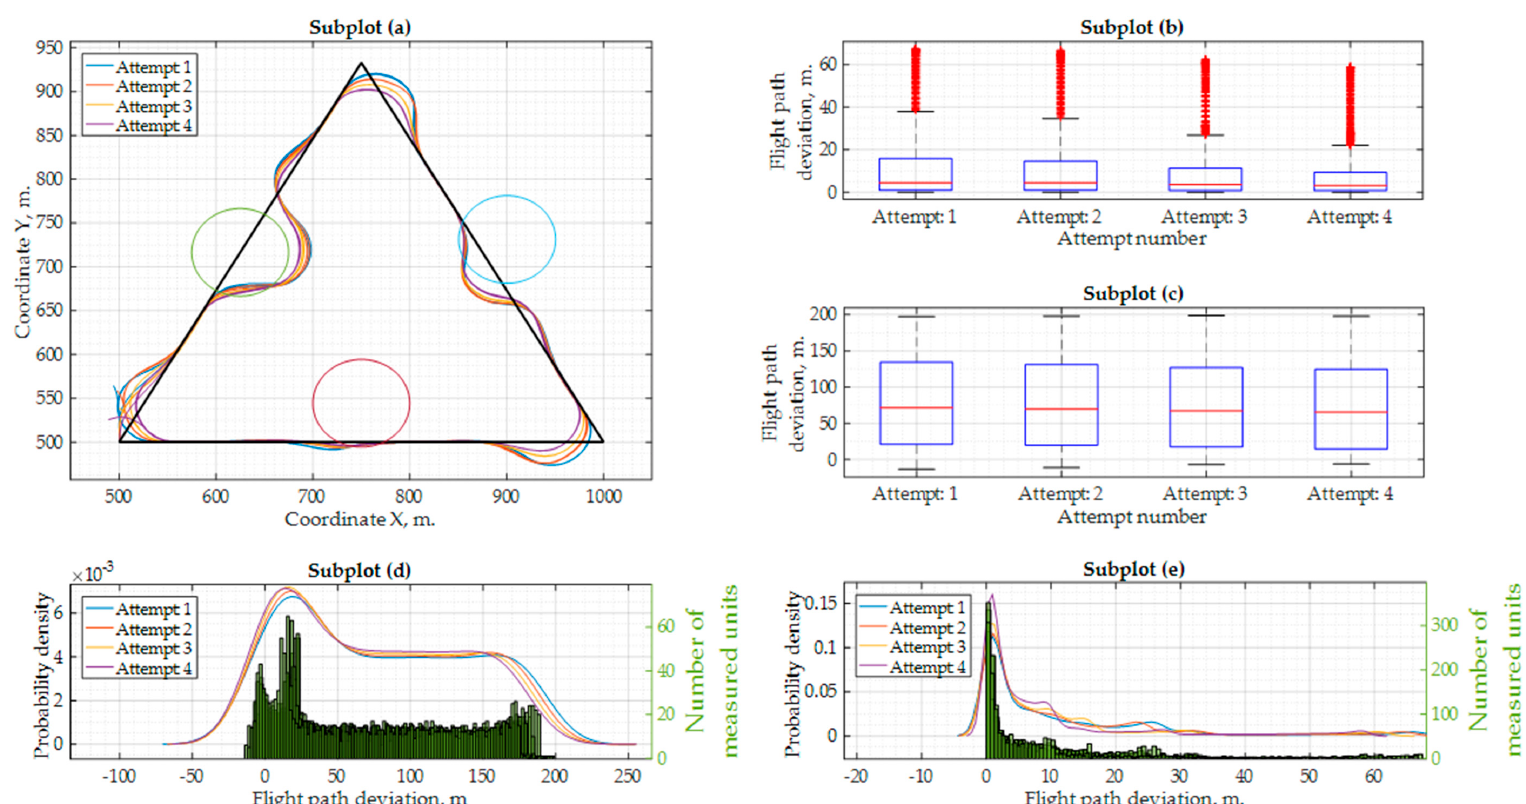
Figure 10. Results of the Software-in-the-Loop simulation with the “ArduPilot” autopilot with the flight speed at 15 m/s: ( a ) flight mission, flight trajectory and ground obstacles; ( b ) flight deviation from the standard flight mission path (when using ground obstacle avoidance); ( c ) flight deviation from the ground obstacle area boundary of 50 m. (when using ground obstacle avoidance); ( d ) probability density values and quantity of measurements for every flight path deviation value (standard mission); ( e ) probability density values and quantity of measurements for every flight path deviation value (from ground obstacle area